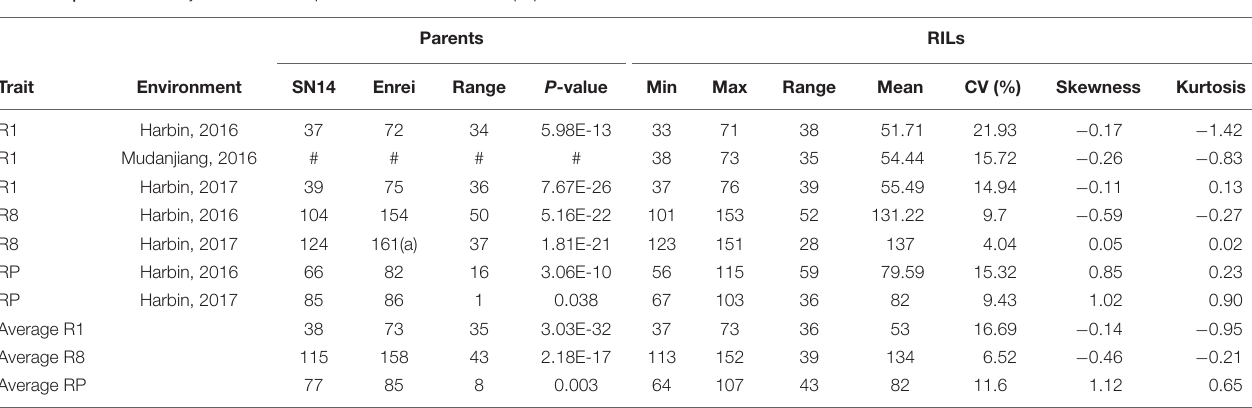
FIGURE 3 | The genetic map of RIL populations. (A,B) Genetic map of SE and DW RIL population constructed with HighMap software, respectively. Chr., chromosome. TABLE 1 | Statistical analysis result of the parents and the whole SE